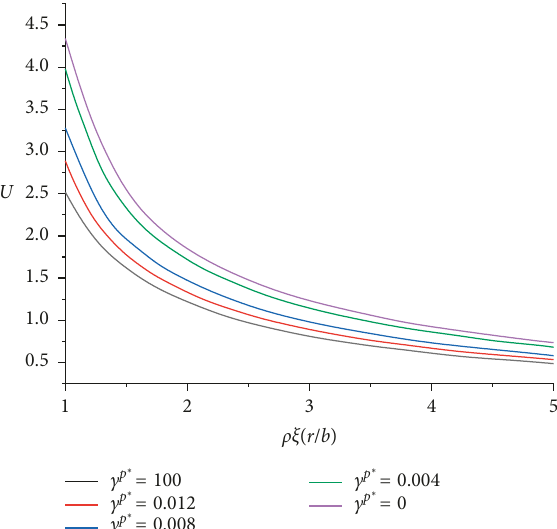
Figure 9: Comparison of dimensionless displacement for M-C rock mass.